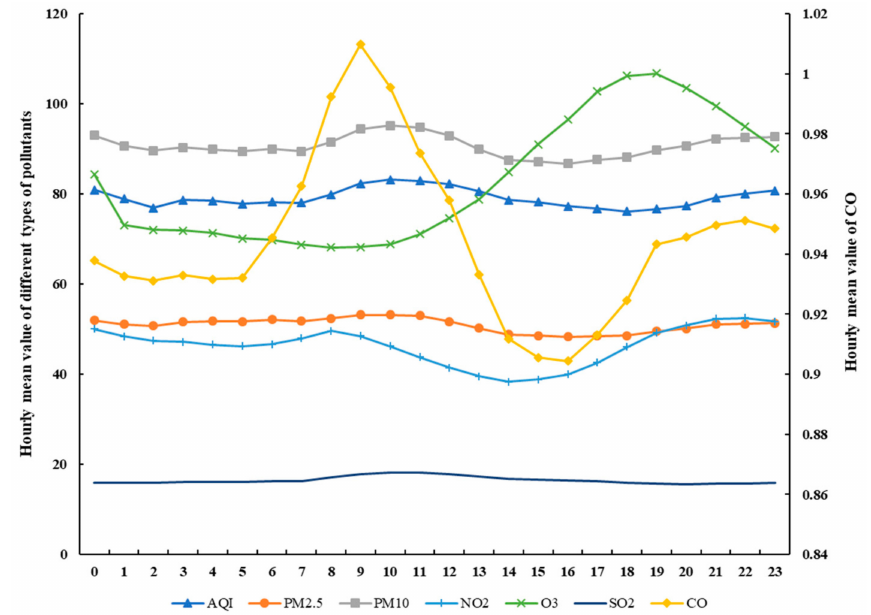
Figure 6. The average level of air pollution in each hour within a